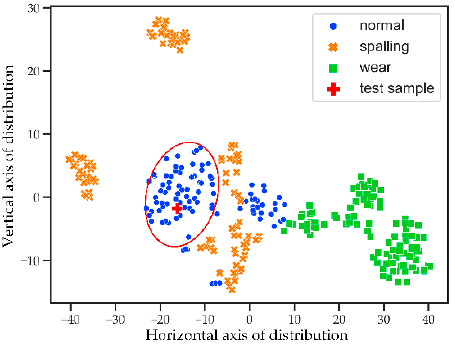
Figure 10. Visualized feature distribution of the test sample and the learning dataset.